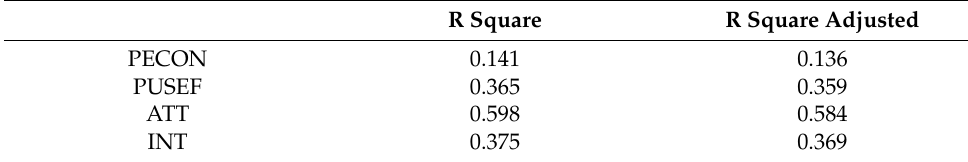
Table 8. Coefficient of Determination.